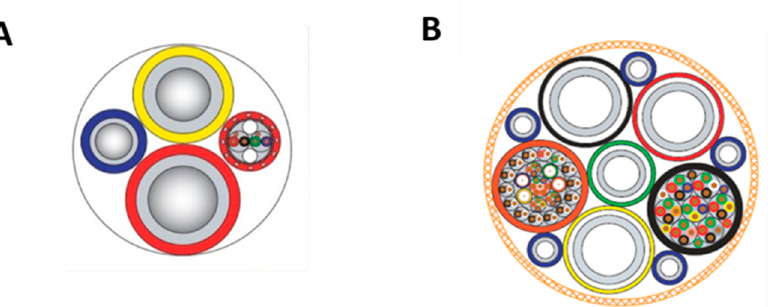
Figure 2. Examples of umbilical cross sections. Different supply lines exist for different purposes. ( A ): Umbilical from diving bell to diver (Ø: ~4.5 cm). ( B ): Umbilical from diver’s support vessel to diving bell (Ø: ~6 cm). Reprinted with permission from Miller [4]. Copyright 2021 Bay-Tech Indus- tries.